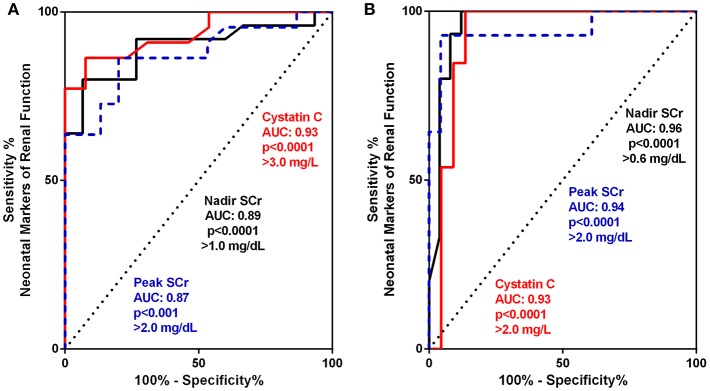
(A,B) Receiver operating curve (ROC) and area under the curve (AUC) for biomarker assessment of prediction to early progression to end stage kidney disease (ESRD) (Group 3) (A) and advanced chronic kidney disease (CKD 3–5 + ESRD) Group 2 and 3 (B).